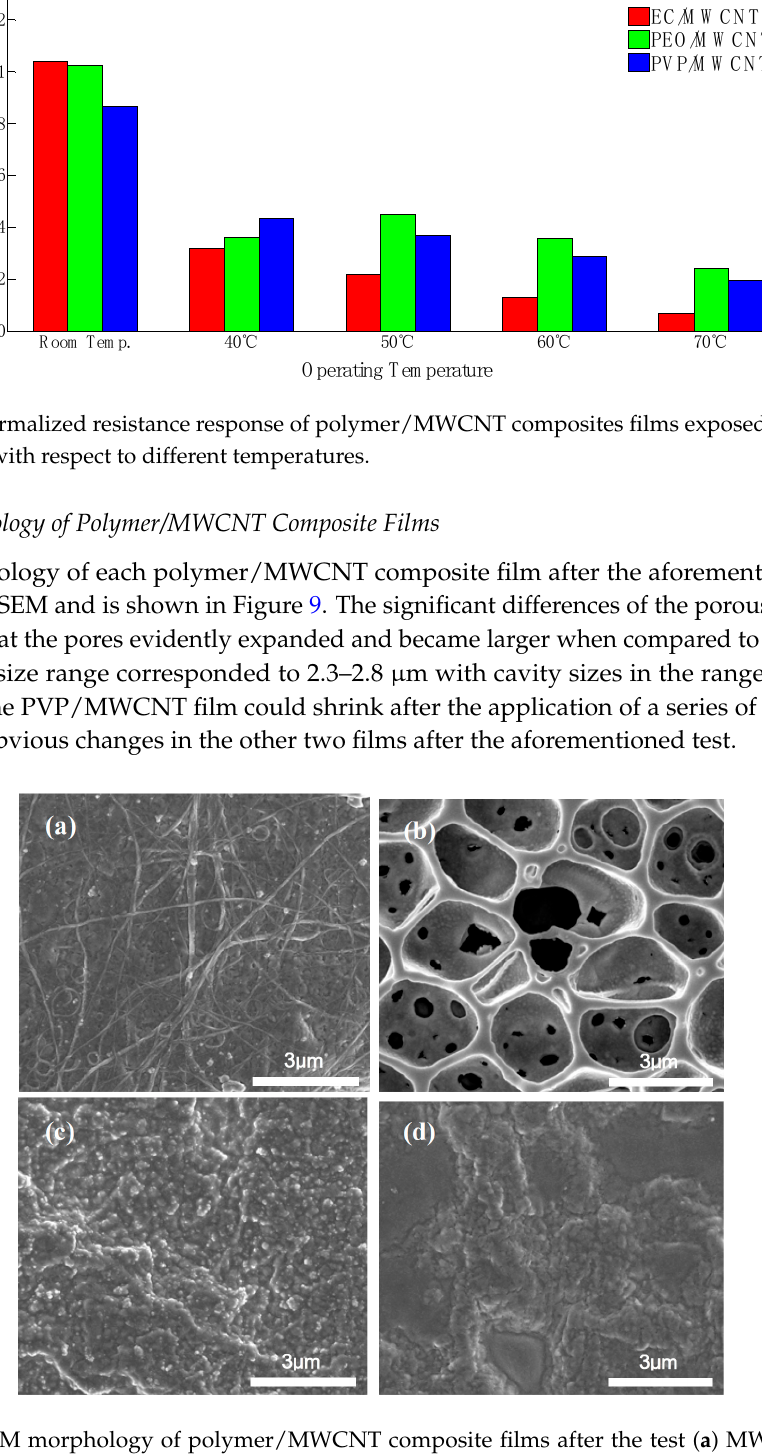
Figure 9. SEM morphology of polymer/MWCNT composite films after the test ( a ) MWCNT film; ( b ) EC/MWCNT film; ( c ) PEO/MWCNT film; and ( d ) PVP/MWCNT film.